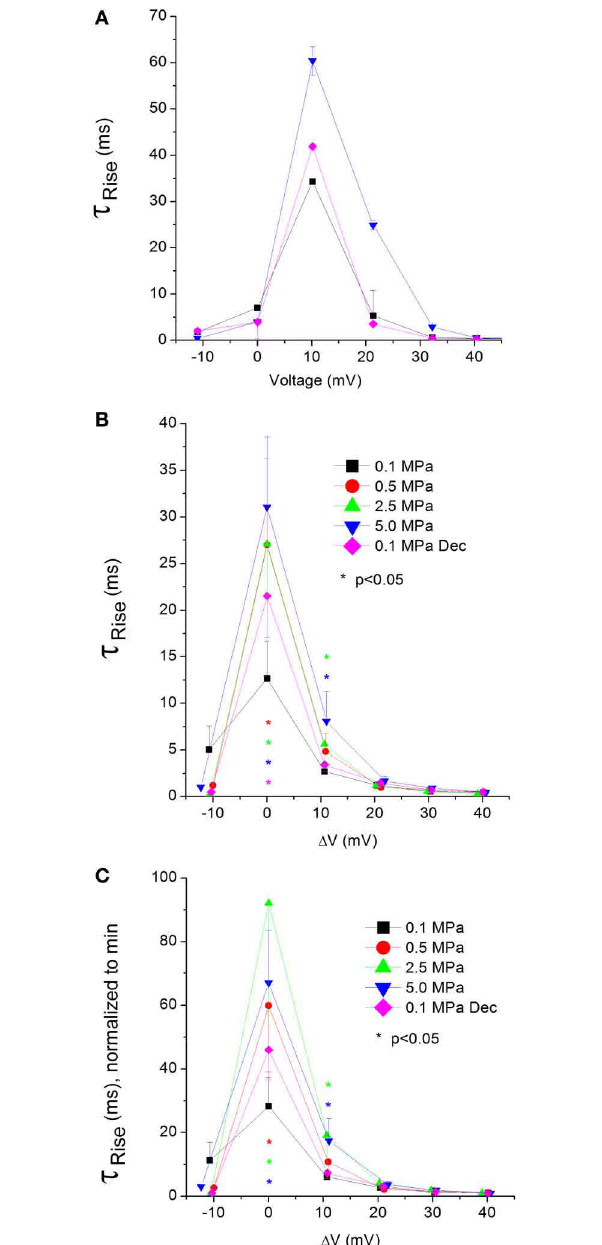
FIGURE 7 | Time constant of current activation ( Rise ) in Ca V 1.2 channel. (A) Rise measured in a single oocyte. (B) Pooled data of Rise from 7 to 16 oocytes. (C) Normalized Rise : each curve is normalized to its own minimal value and corresponds to its pertinent curve in (B) . Pressures are color indicated. Statistical significance for each point on the curve is indicated by corresponding color asterisks. Holding potential is expressed as in Figure 2 . Dec indicates